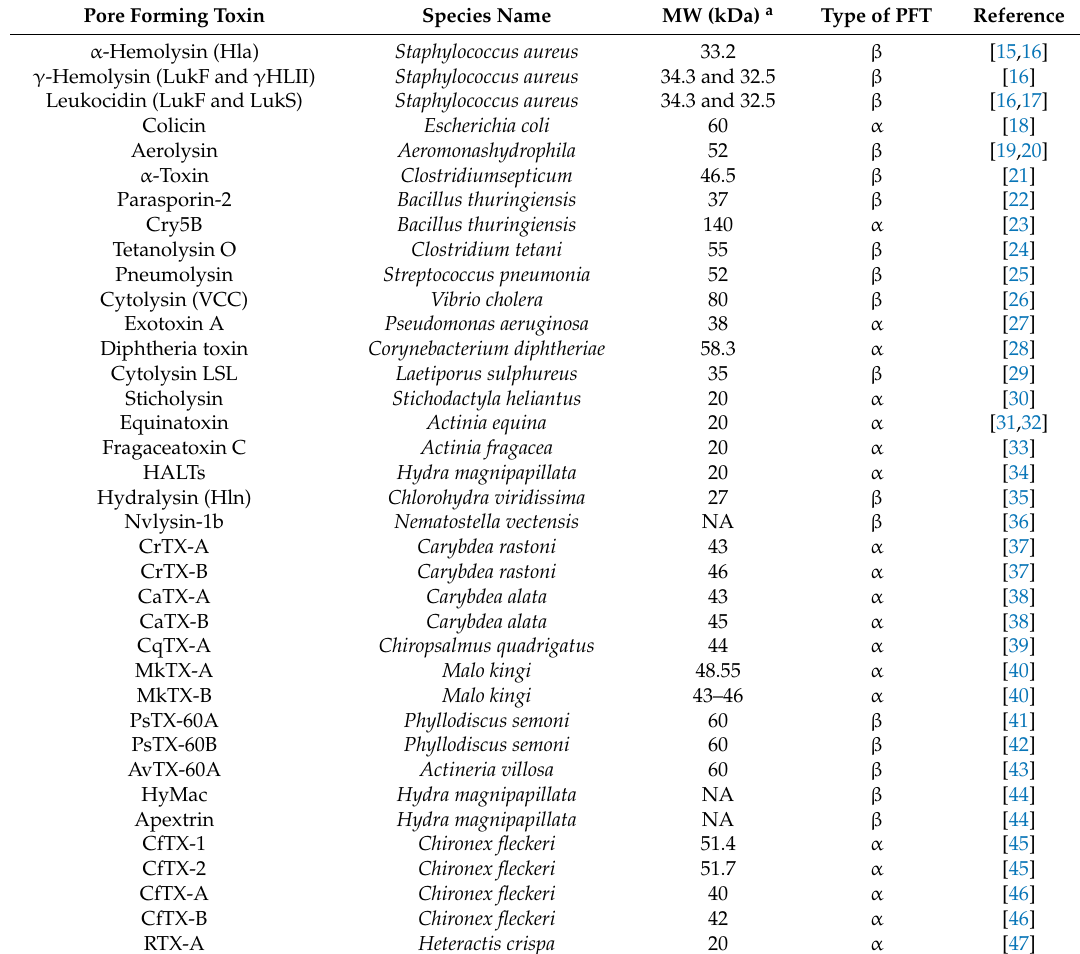
Table 1. Summary of PFTs described in this